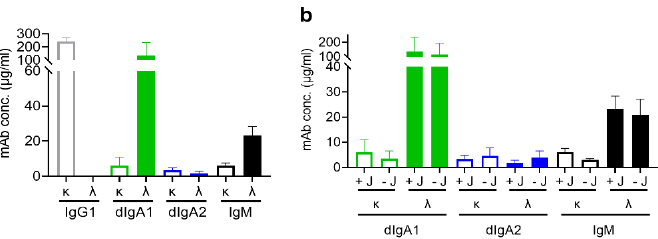
Figure 4. Expression of recombinant mAbs of different Ig classes without variable heavy and light regions. Antibody concentrations in Expi293 cell supernatants were determined 5 days post-transfection using ELISA: ( a ) recombinant mAb levels in culture supernatants when cotransfected with κ or λ light chains lacking variable regions; ( b ) concentrations of recombinant mAbs lacking variable regions in the presence or absence of a J-chain-expressing plasmid. In the absence of J chains, IgAs are expressed in multiple forms [16]. Bars representing IgG1 (grey), IgA1 (green), IgA2 (blue), and IgM (black) are either open bars for the κ or solid bars for the λ light-chain versions. The error bars represent the standard errors of the means. Data are representative of two independent experiments.